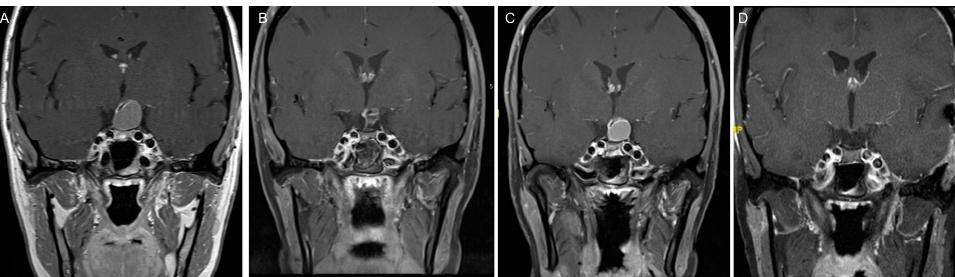
Figure 3. 27-year-old female patient, presenting with amenorrhea and disturbed peripheral color vision. ( A ) MRI for further analysis showed a cystic tumor with compression of the pituitary gland. ( B ) She first underwent transsphenoidal cyst fenestration and partial resection, which she recovered from well with full recovery from her visual deficits. Histopathology diagnosed an adamantinomatous CP. ( C ) Within 6 months, a progression of the cyst was observed, and she again developed visual field deficits and disturbed color vision. ( D ) She then underwent pterional craniotomy for complete tumor removal and additionally received proton beam therapy as adjuvant therapy. Her visual field deficits improved over time, while her endocrine deficits persisted, requiring hormonal substitution. Nowadays, the pediatric approach with neuroendoscopic cyst fenestration followed by proton beam therapy could have been applied for this case, while craniotomy is the more traditional approach.